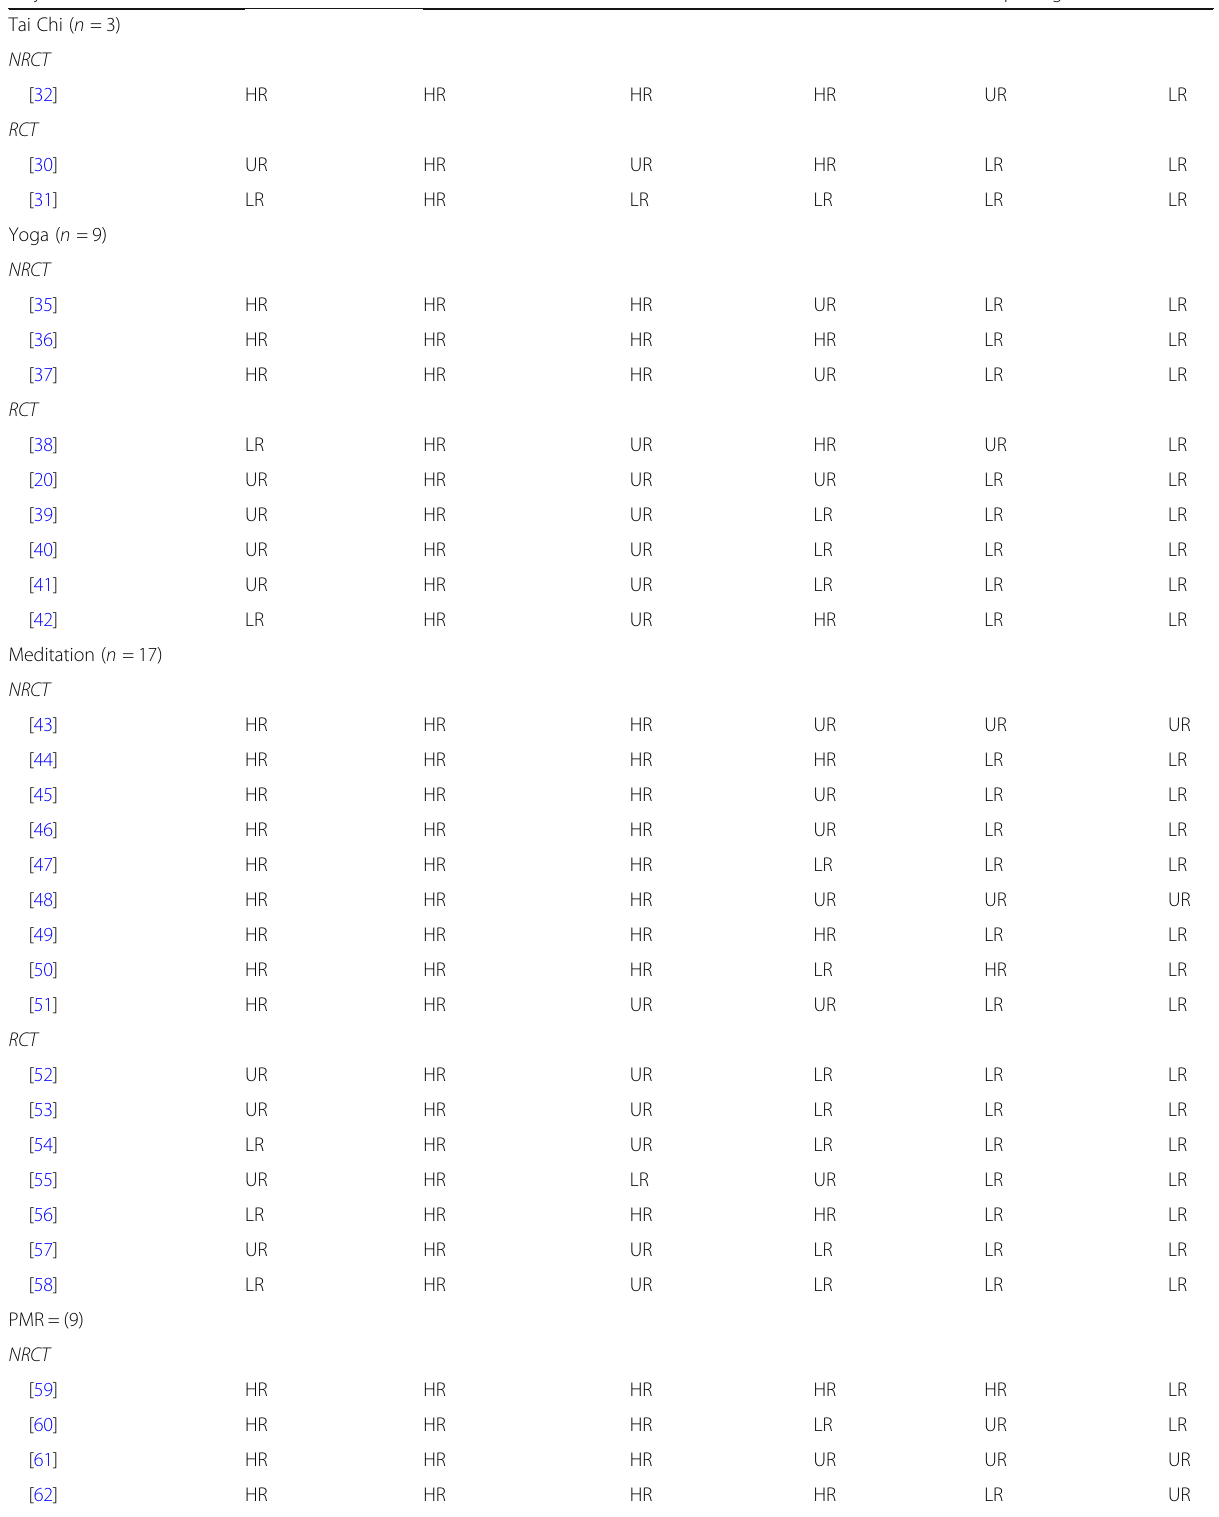
Table 3 Risk of bias of included studies (Quantitative